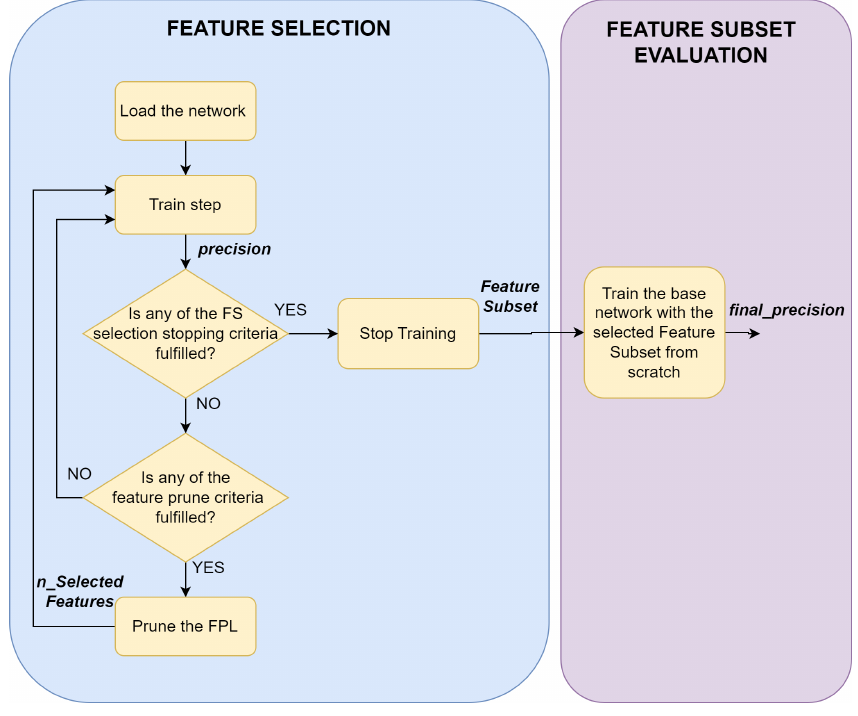
Figure 5. Flowchart of the proposed FS